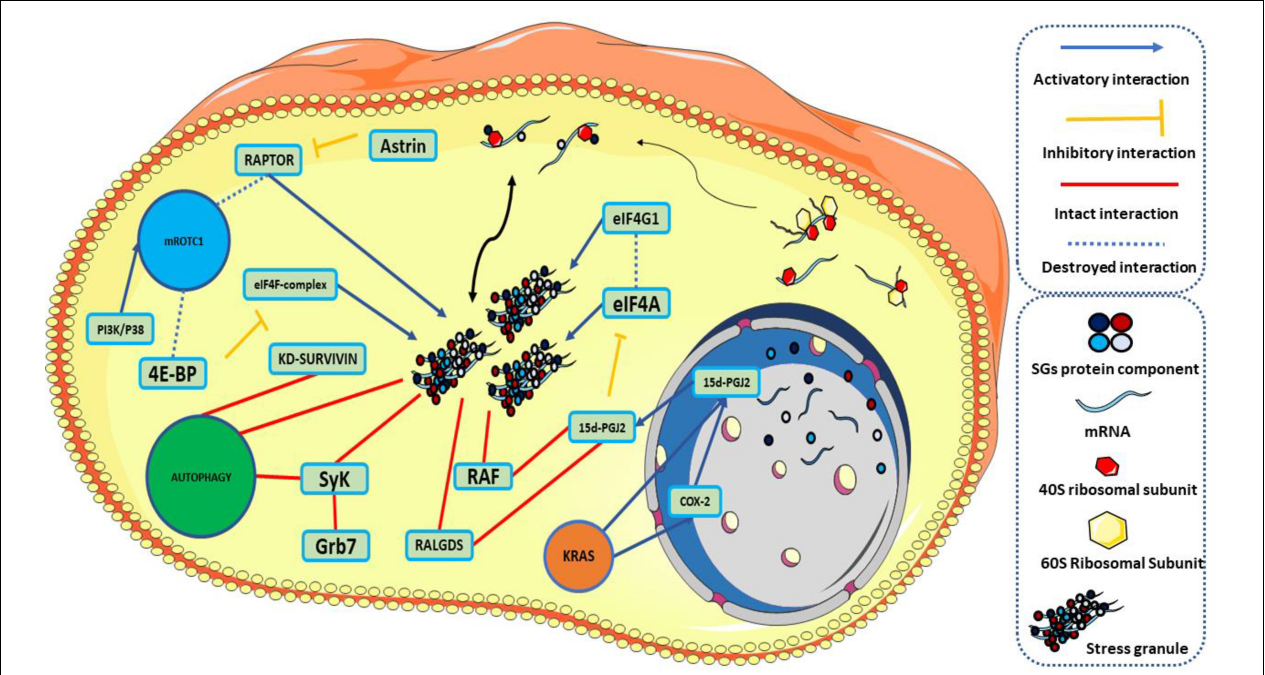
FIGURE 6 | Traces of stress granules in signaling pathways. Under natural conditions, stress granules are assembled and disassembled under an equilibrium. KRAS causes up-regulation of 15d-PGJ2 directly or through COX-2. On one side of the pathway, 15d-PGJ2 interacts with RALGDS and RAF to form SGs. 15d-PGJ2, on the other hand, targets eIF4A, destroys its connection to eIF4G, stops the translation process, and leads to the formation of SGs. Knocking down survivin is associated with an increase in the number of SGs and activation of autophagy. SyK phosphorylation by Grb7 localizes SyK in the structure of SGs and activates autophagy. Localization of RAPTOR in the SGs structure by up-regulation of astrin leads to an increase in the production of SGs. On the other hand, inhibition of mTORC1 inhibits phosphorylation of 4E-BP and the formation of eIF4F complex and causes the formation of SGs. 15d-PGJ2: 15-Deoxy-delta (12,14)-prostaglandin J (2), KD-survivin: knocking Down-Survivin. This graphical figure was created using the vector image bank of Servier Medical Art